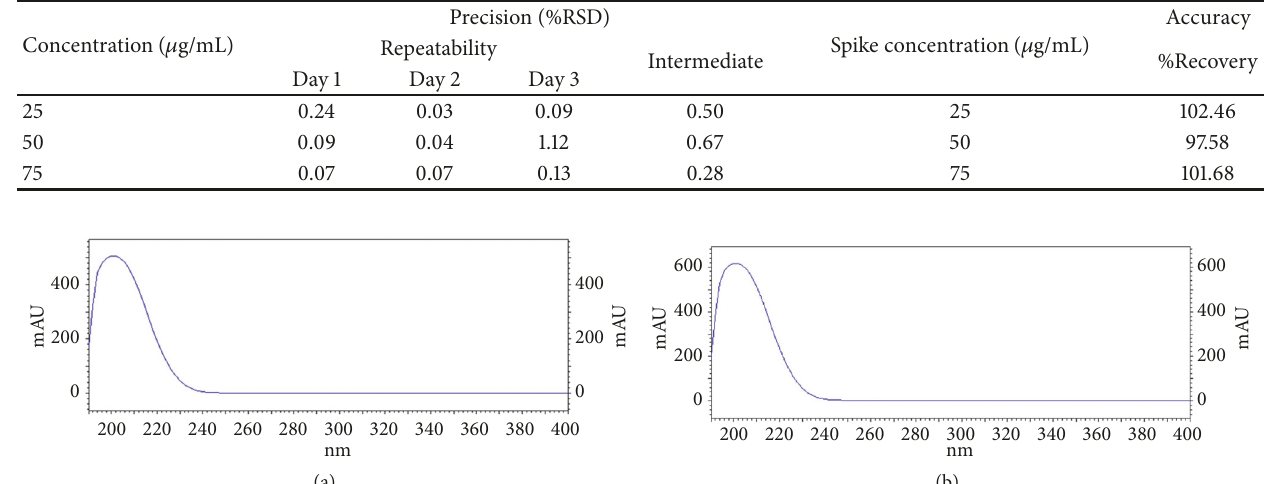
Table 2: Precision and accuracy results.